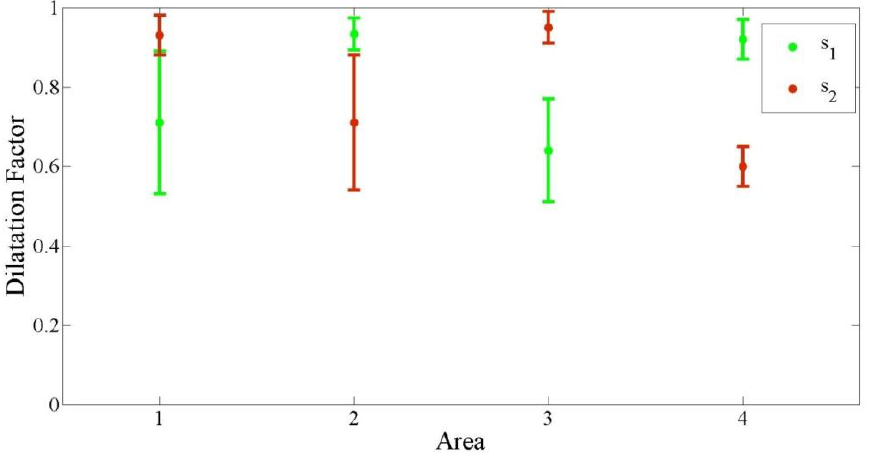
Figure 11. Average dilatation factor for horizontal (s operators in the four